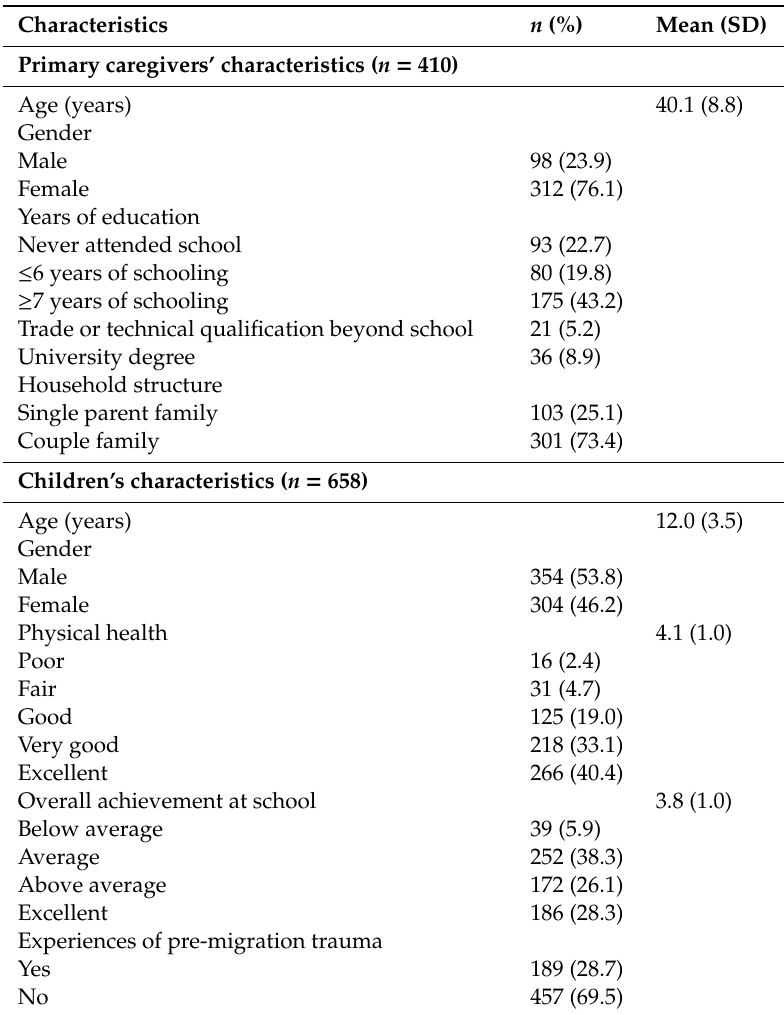
Table 2. Participants’ characteristics.